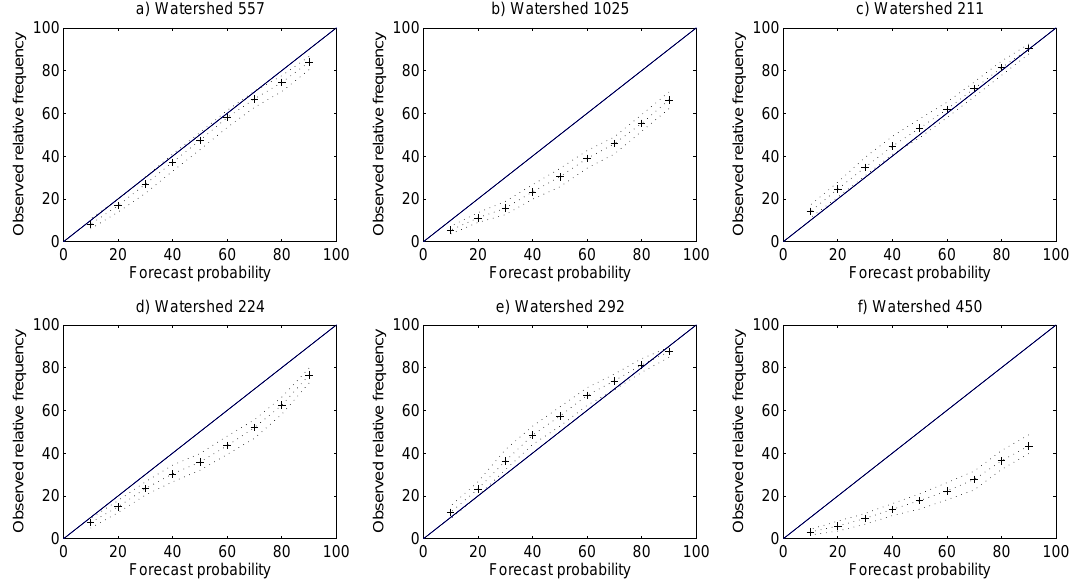
Fig. 7. Reliability plots for the same catchments as in Fig. 5, for discharge larger than quantile 50 of the observation time series. Dashed lines depict the 95% confidence